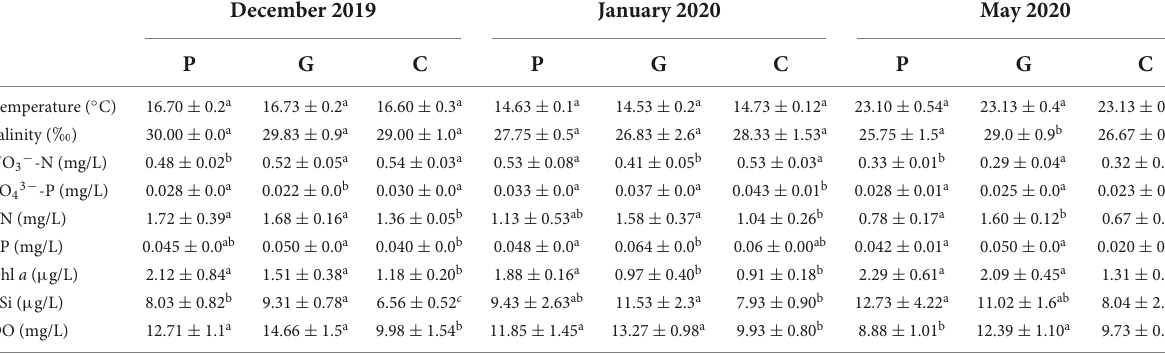
TABLE 1 Environmental parameters of each sample from December 2019 to May